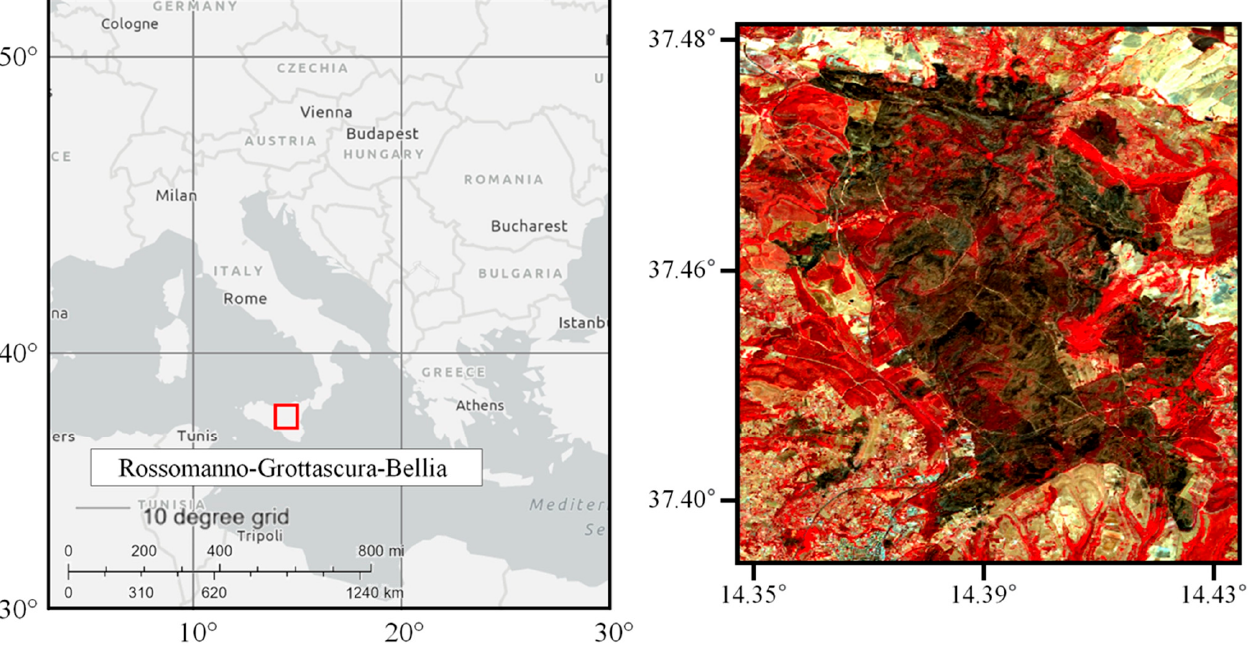
Figure 1. The study area’s location, Rossomanno-Grottascura-Bellia, is in the south of Italy ( Left ) and the post-fire Sentinel-2 image ( Right ). The RGB color composite is from NIR, red, and green pseudocolor images.